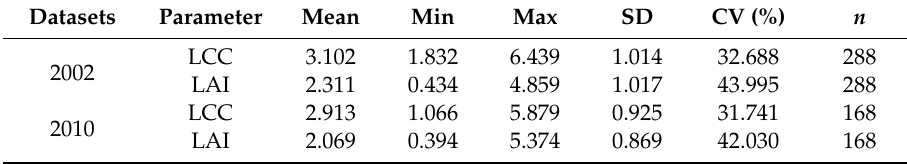
Table 3. Results of the statistical analysis of the measured winter wheat LCC (mg g − 1 ) and